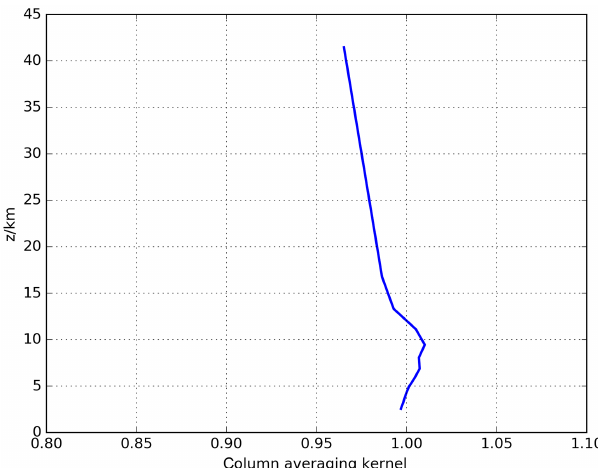
Figure 2. Column averaging kernel for a typical methane retrieval. The retrieval was performed using the simulated NIR and SWIR spectra in Fig. 1.